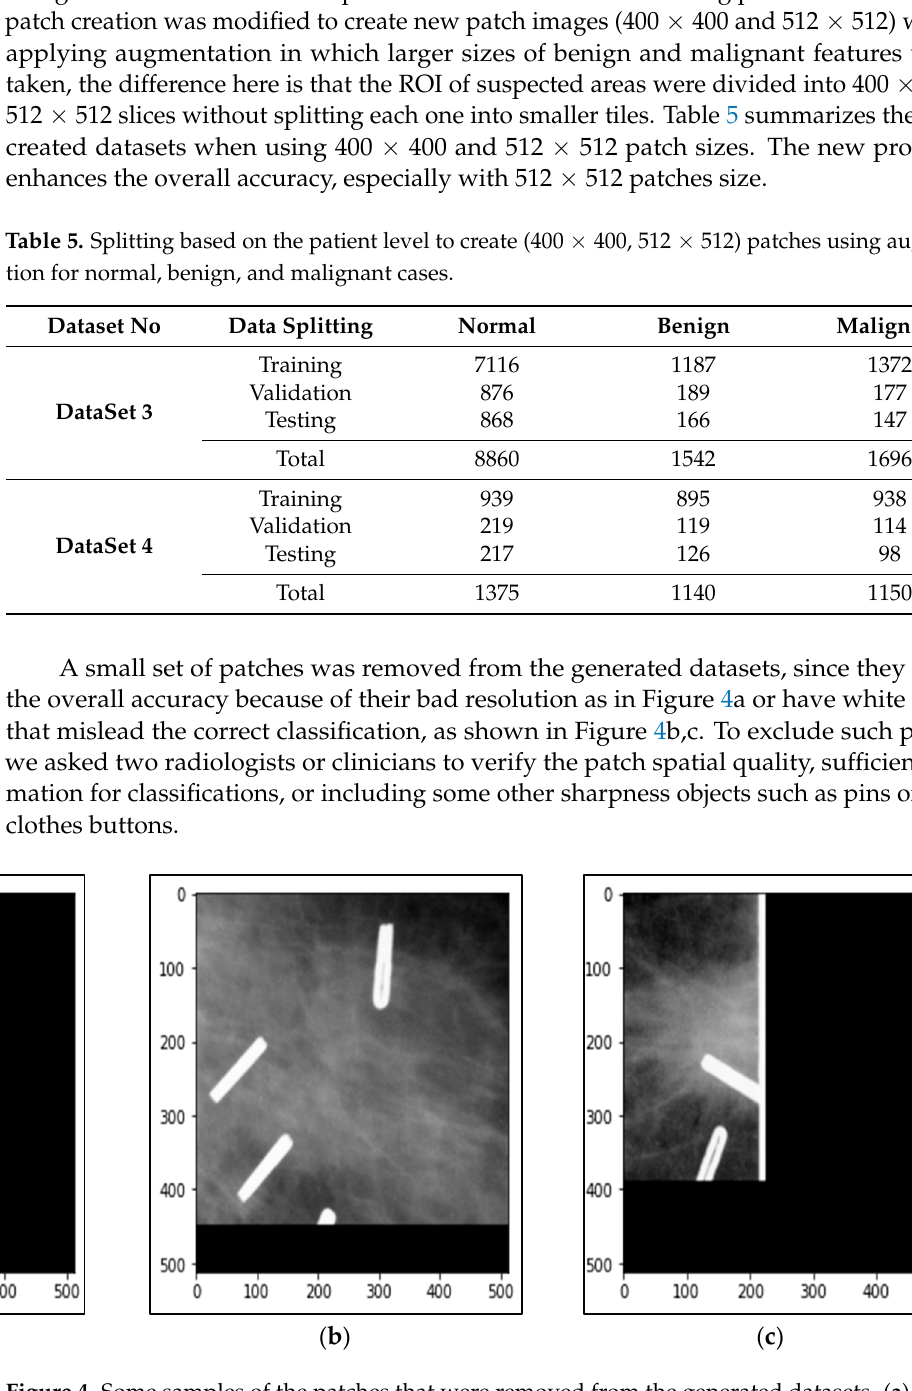
Table 4. Splitting based on the patient level to create (256x256) patches using augmentation for nor- mal, benign, and malignant cases.